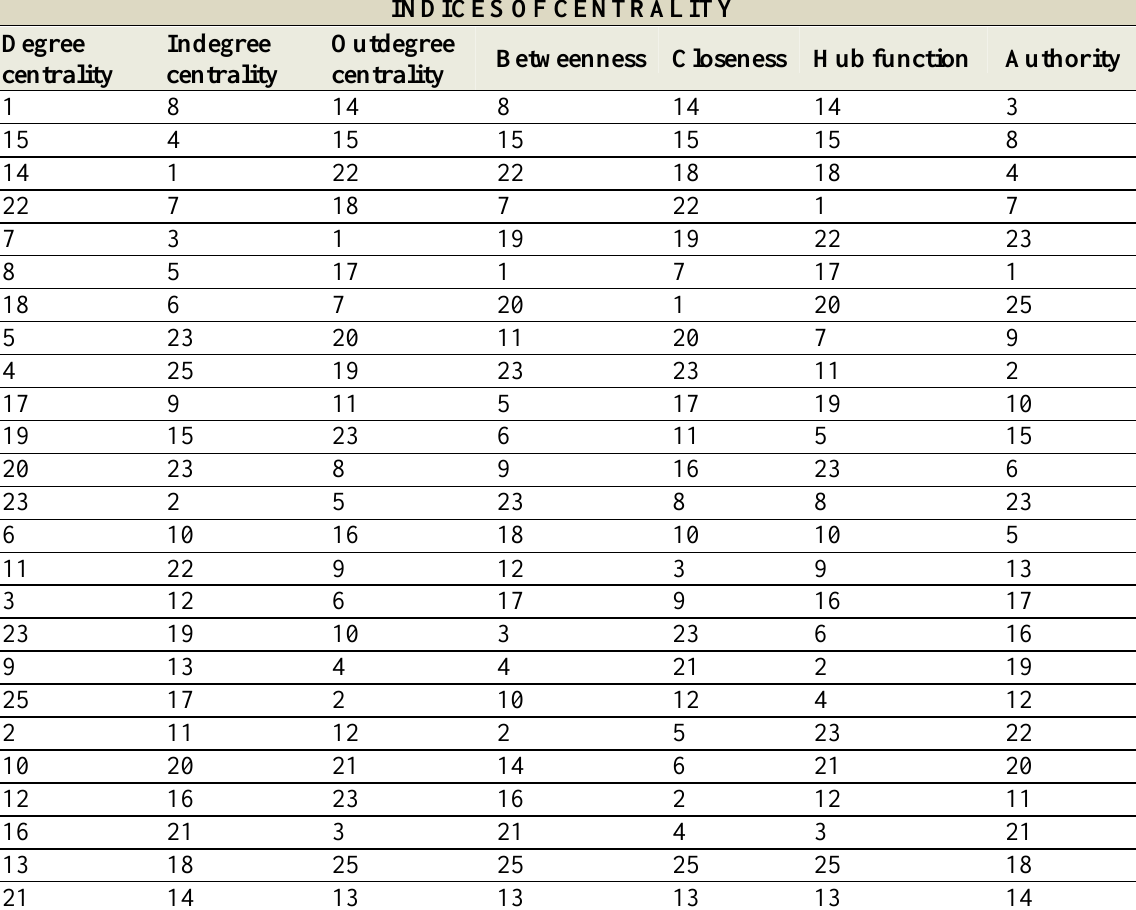
Table 1. Ranking of players by centralityindices (based on percentages – for the numeric codes, see Table 3 in theannex) INDICES OF